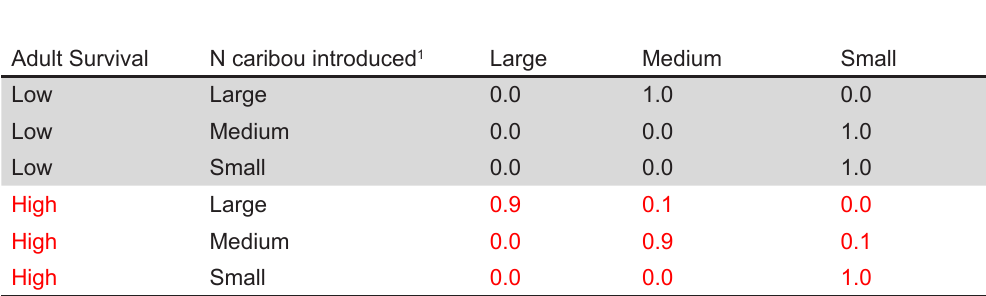
Table A4. Conditional probability table for node translocated caribou surviving. Parent nodes and their state Translocated caribou surviving Adult Survival